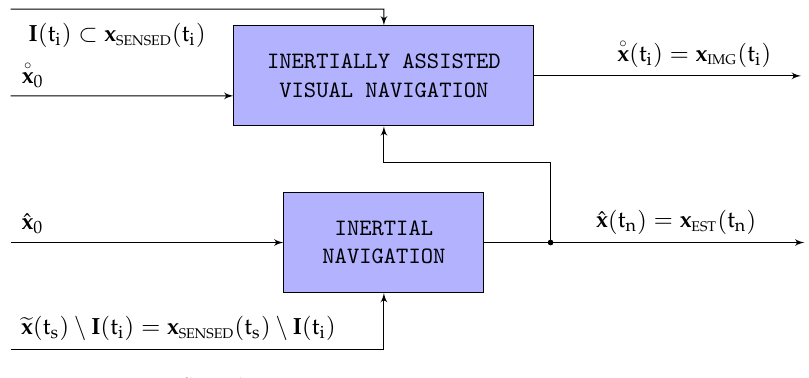
Figure 7. IA-VNS flow diagram.